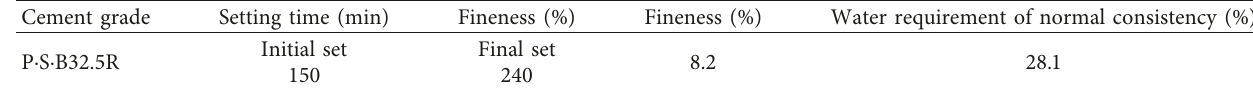
Table 3: Main performance indices of cement.